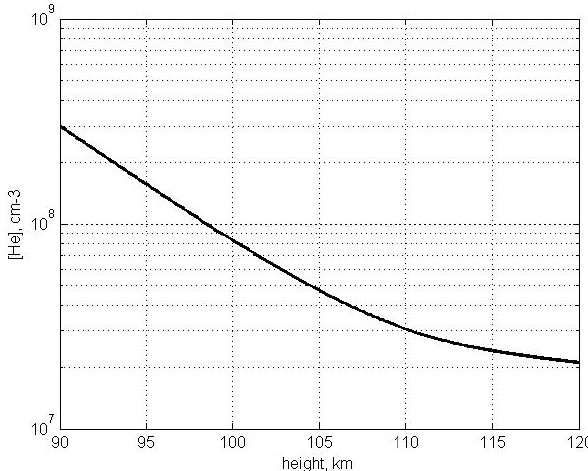
Fig. 5b. The same as in Fig. 5a but in summer solstice with K m 6 × 10 6 cm 2 s − 1 , z m = 92km, and s = 0 . 01km − 2 .